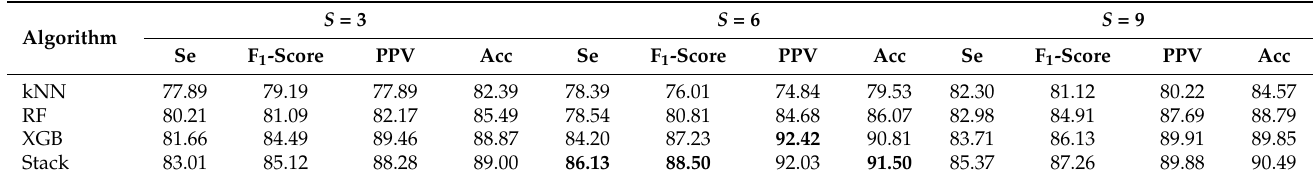
Table 7. Performance comparison of different classifiers for S = 3, 6, and 9. The numbers are in percentage and the highest performances of the different models are given in bold.